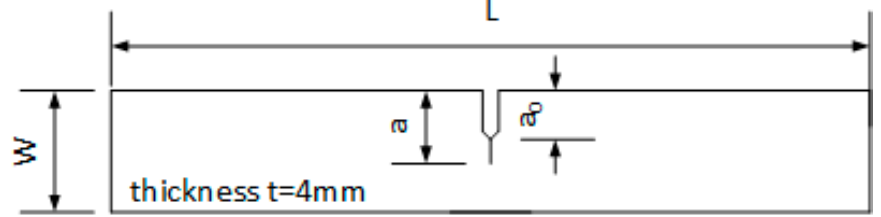
Figure 5. Scheme of the specimen subjected for the bending test in Gasiak & Rozumek [35] experiment, L = 120 mm, W = 20 mm, notch length a 0 = 5 mm (notch tip angle 60 ◦ , root radius ρ = 5 mm), a —fatigue crack length.